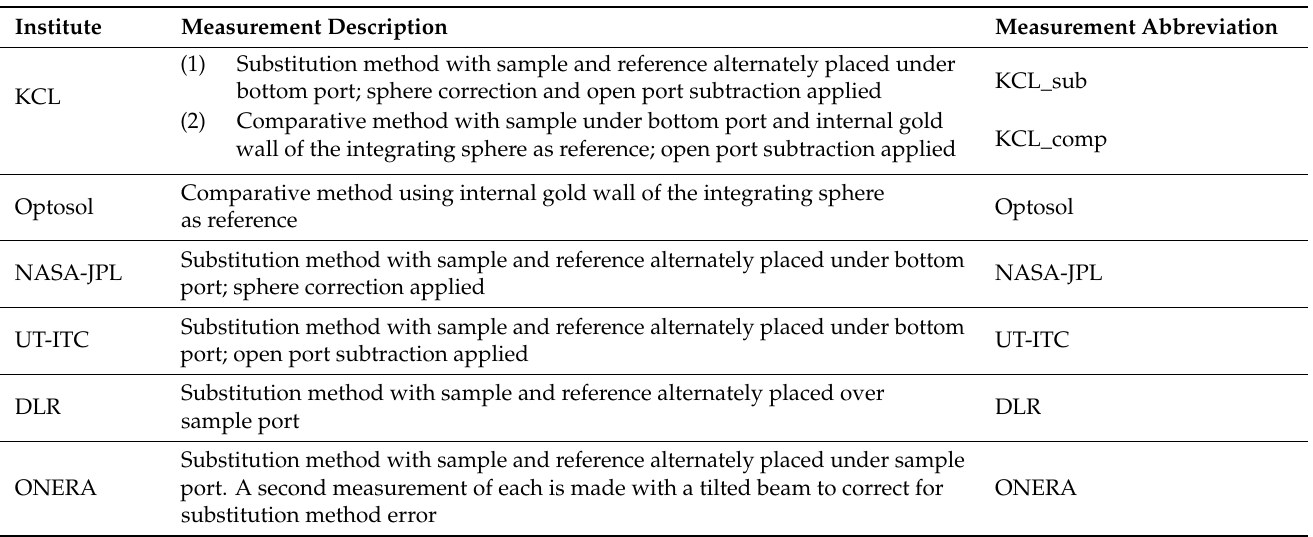
Table 2. Details of the methods of spectral emissivity (SE) determination used by each participant laboratory, with abbreviations identifying how the individual measurements will be subsequently referred